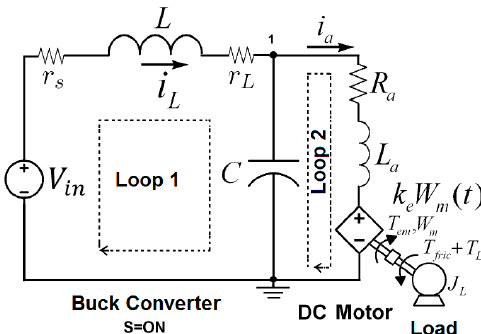
Figure 3. Electromechanical system with the switch ON.